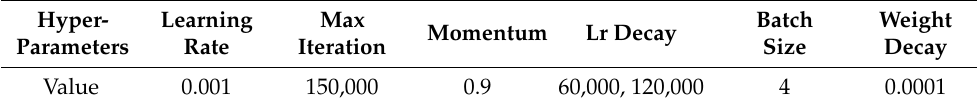
Table 1. Hyper-parameters of FPN series